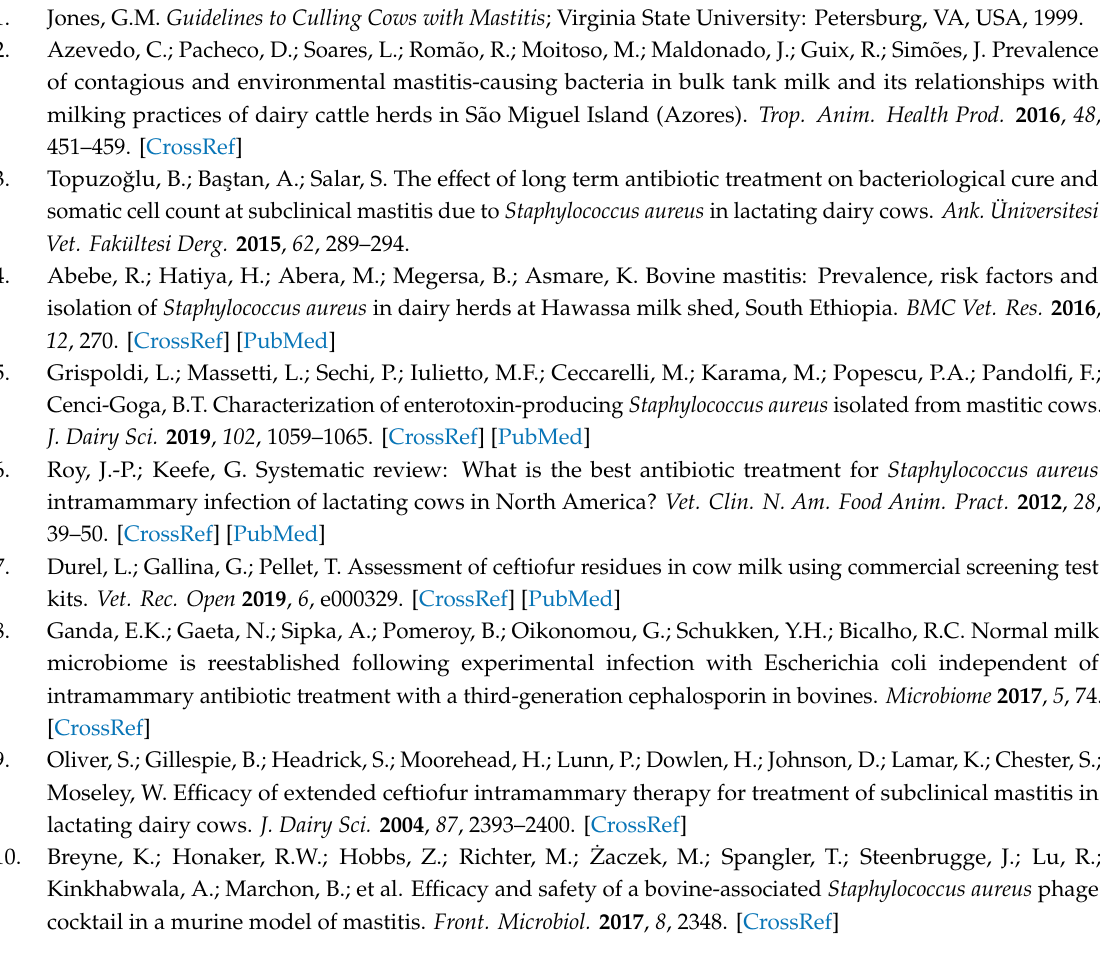
Table S1: List of conserved essential targets in 20 mastitis-causing pathogens and their corresponding drugs from Drugbank database, Table S2: List of unique drugs from Drugbank database for each of the 20 mastitis causing